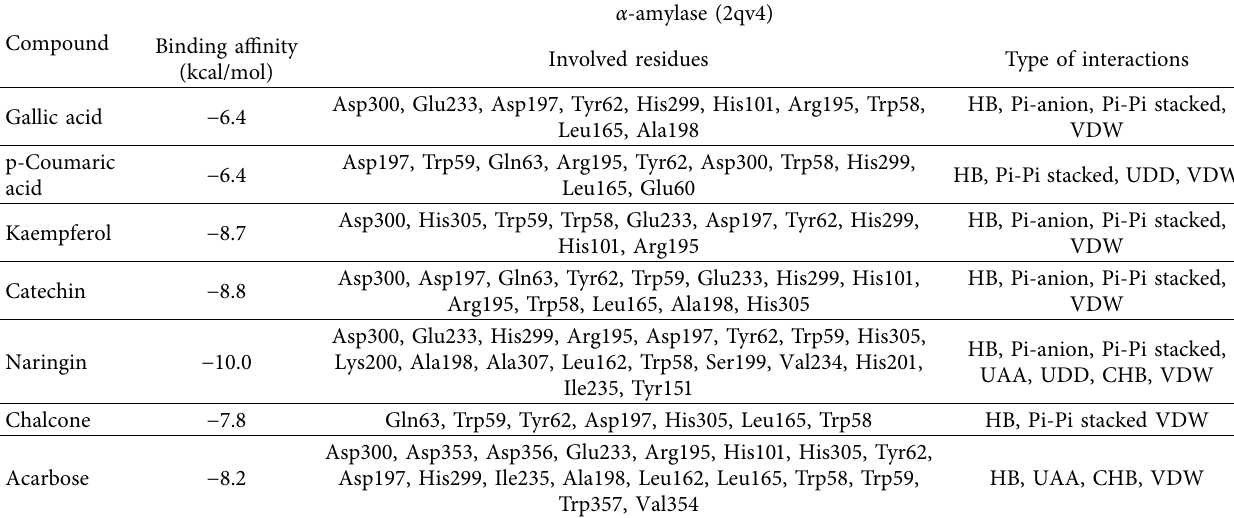
Table 7: Docking results against human pancreatic α -amylase enzyme.